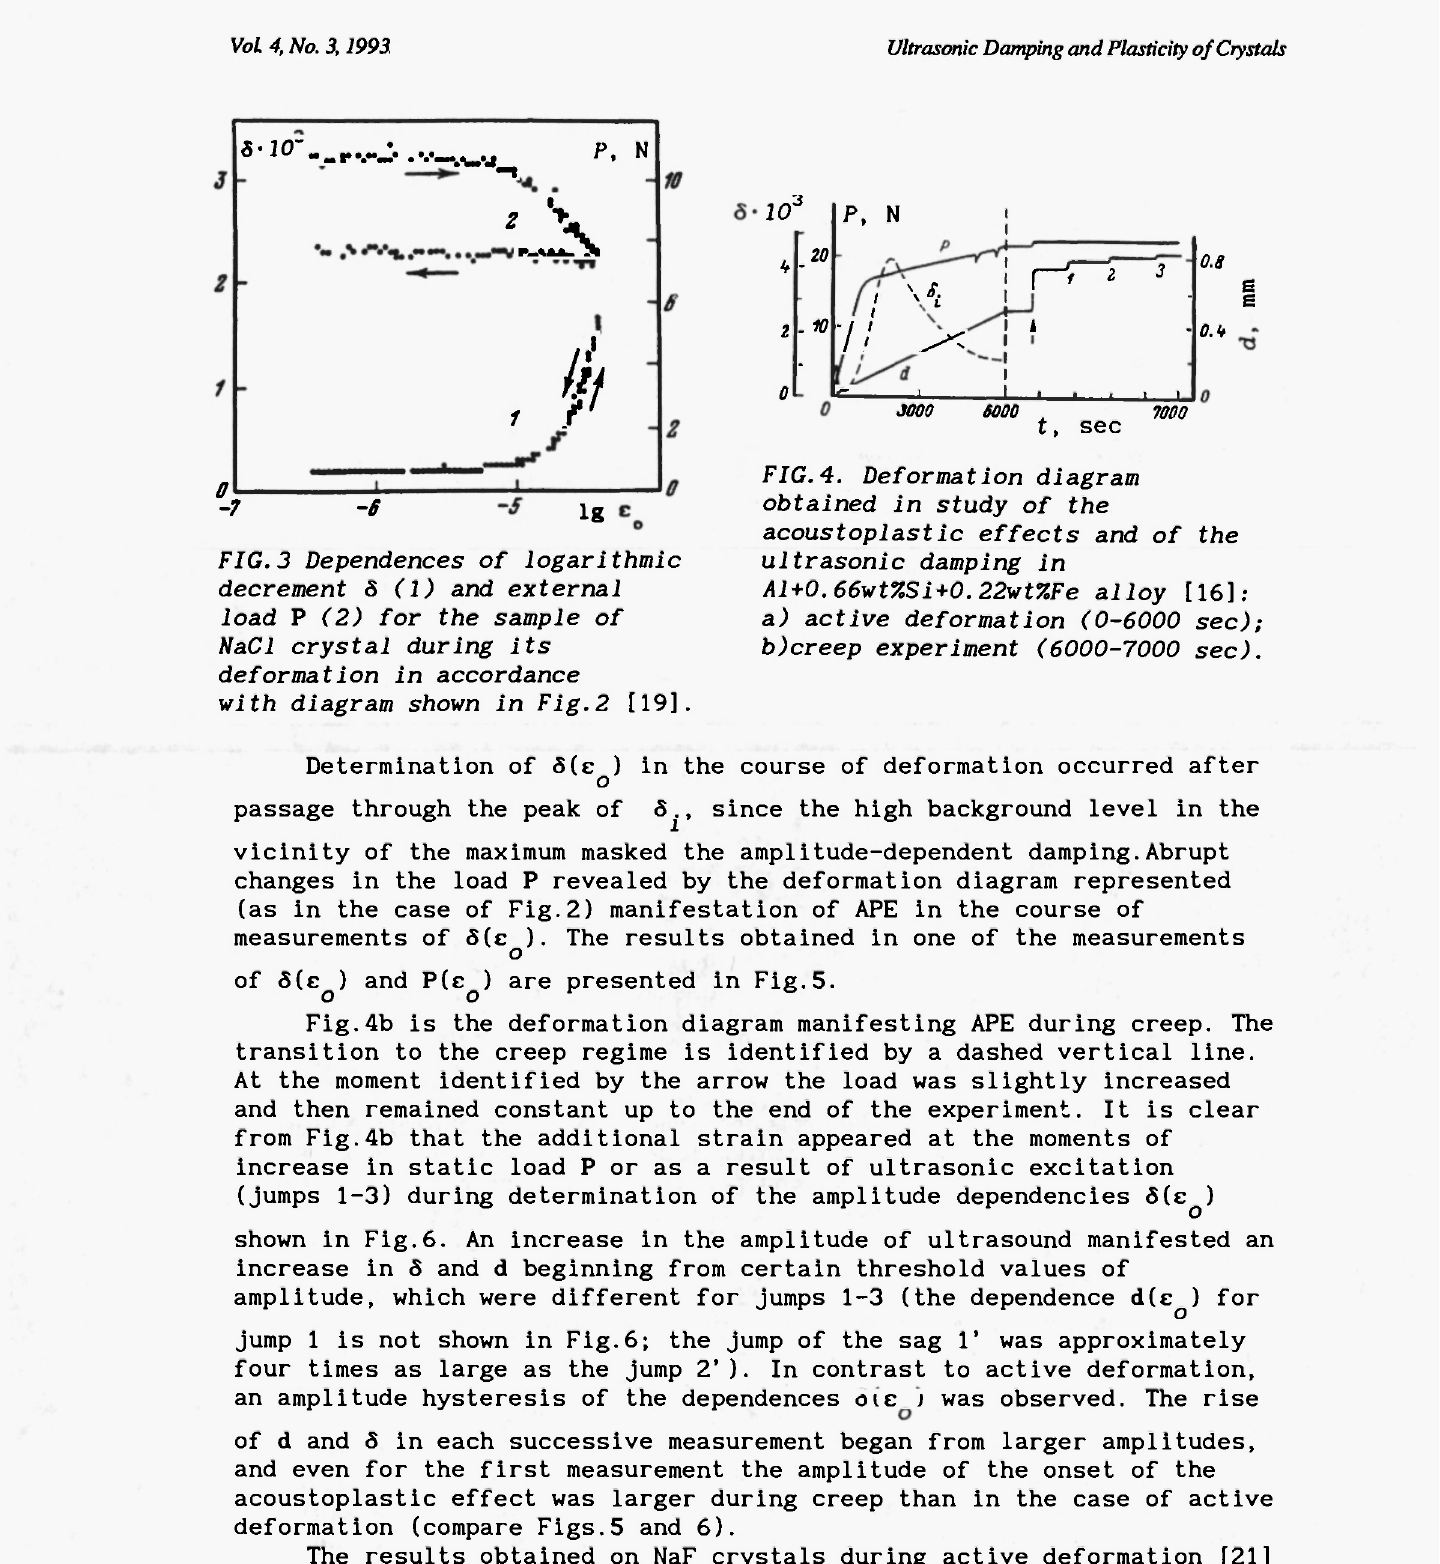
FIG.4. Deformation diagram obtained in study of the acoustoplastic effects and of the ultrasonic damping in Al+O.66wt%Si+0.22wt%Fe alloy [16]; a) active deformation (0-6000 sec); b)creep experiment (6000-7000